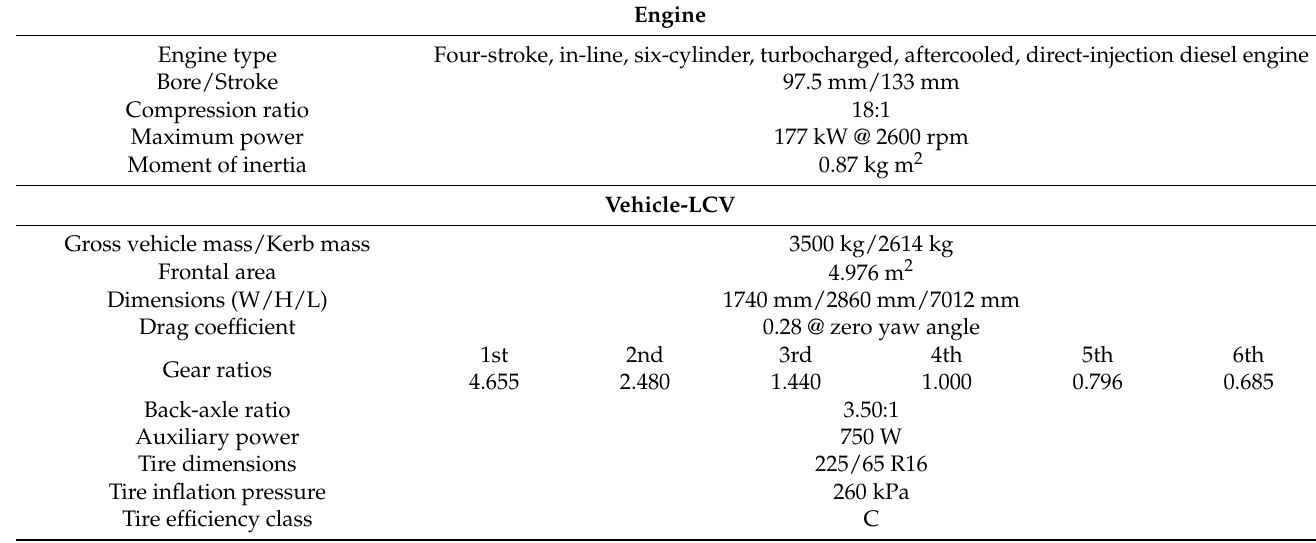
Table 4. Engine and vehicle